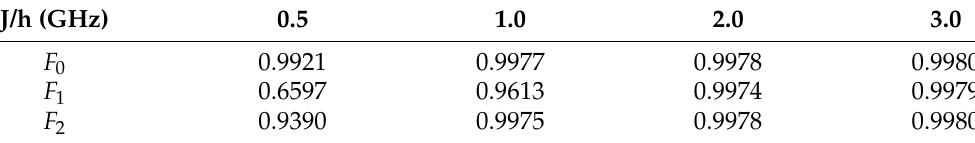
Table 1. Fidelities for CNOT gate operation where F 0 is calculated with the given value of J in the Table, while F 1 and F 2 are calculated with J 1 / h = J / h − 0.2 GHz and J 2 / h = J / h − 0.06 GHz, respectively. J/h (GHz)